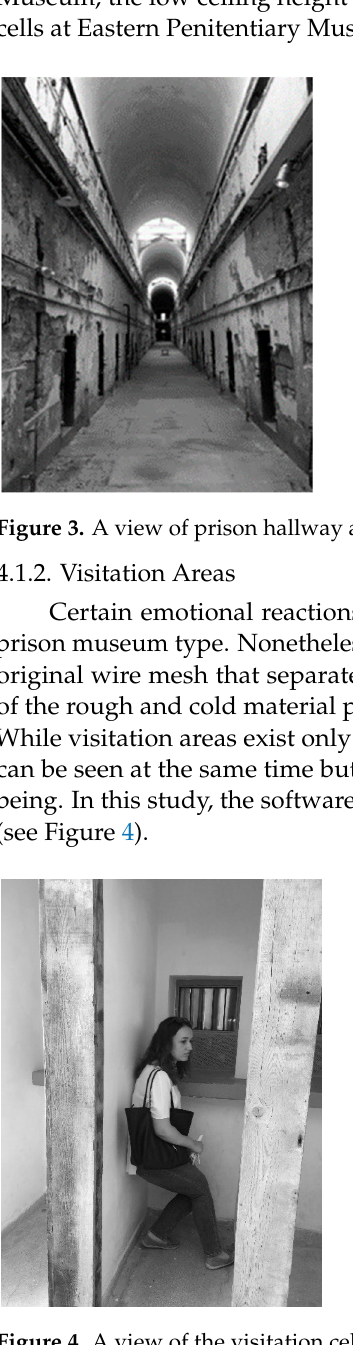
Figure 4. A view of the visitation cell at the Ulucanlar Museum.